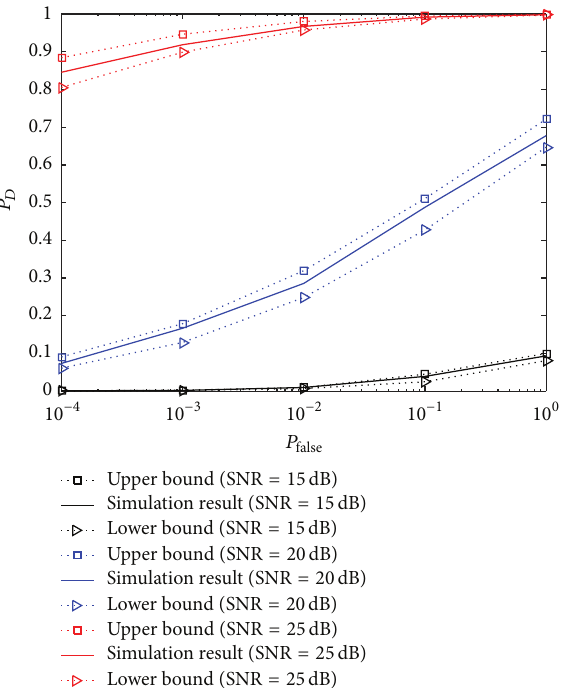
Figure 2: ROC curves near the theory curve of ROC for different SNR. Figure 3: Concentration of ROC curve around the expected performance curve.